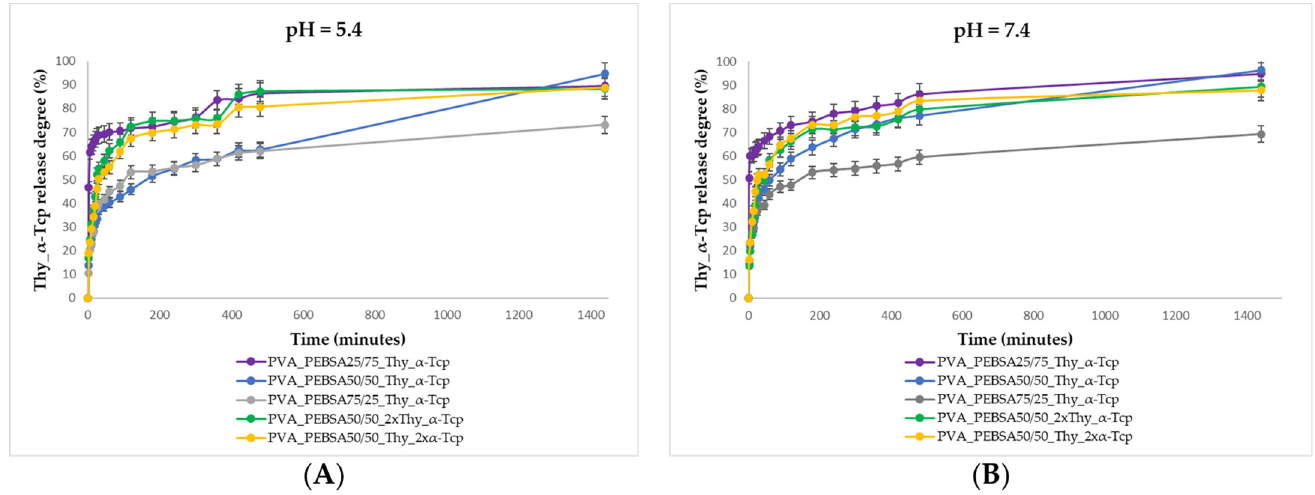
Figure 3. Cumulative release of Thy and α -Tcp at ( A ) pH 5.4 compared to ( B ) pH 7.4. Graphical data are expressed as mean ± standard error of the mean.